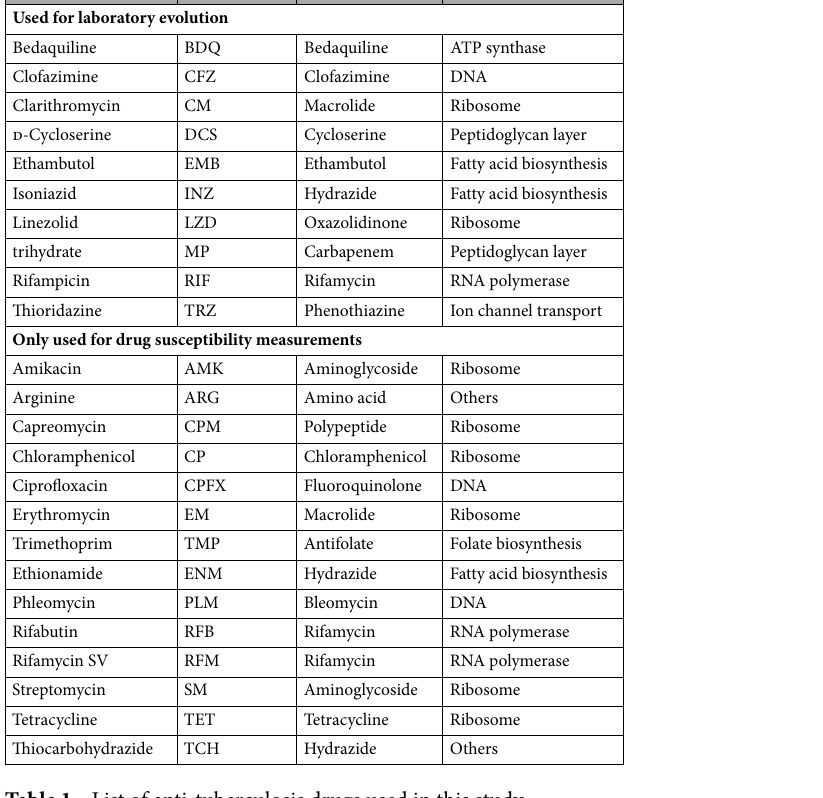
Table 1. List of anti-tuberculosis drugs used in this